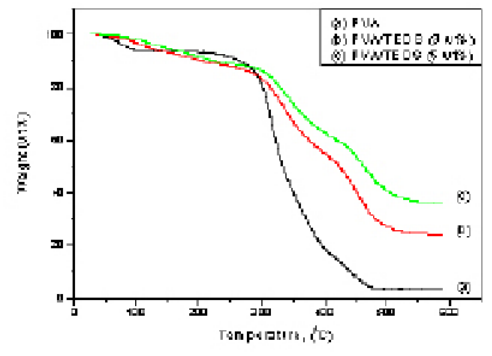
Figure 2. Thermogravimetric analysis of pure PVA and PVA/TEOS matrices (3 wt% and 5 wt%).